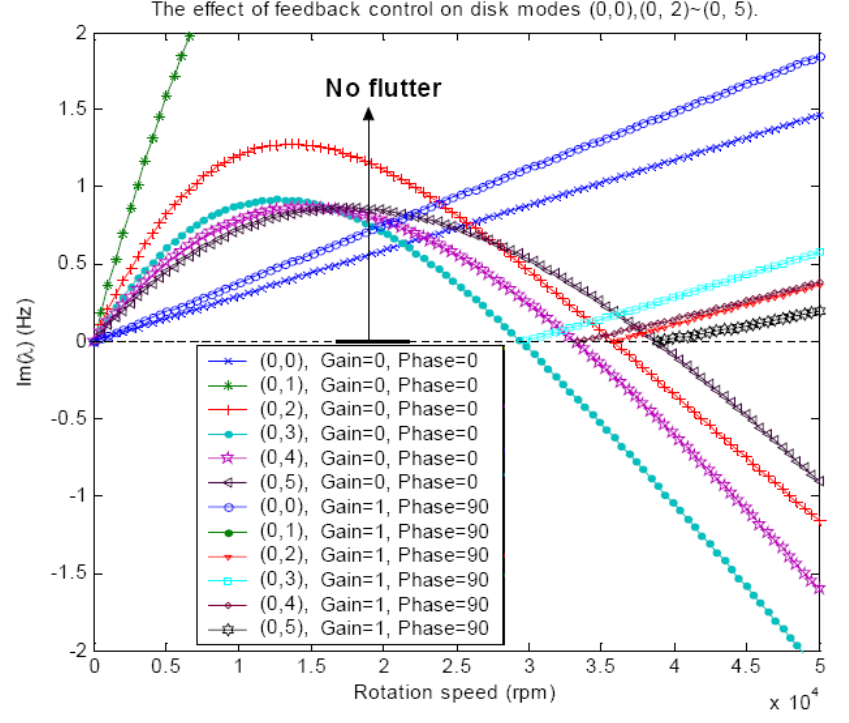
Figure 8. The effect of feedback control on Im ( λ ) with Gain = 1.0 and Phase (shift) = 90° for disk modes (0, 2)~(0, 5) versus rotational